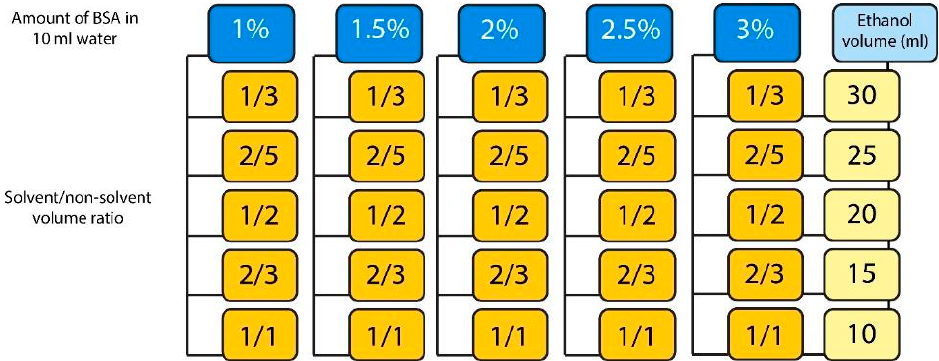
Figure 2. Amount of BSA and solvent/non-solvent volume ratios used to prepare BSA nanoparticles.